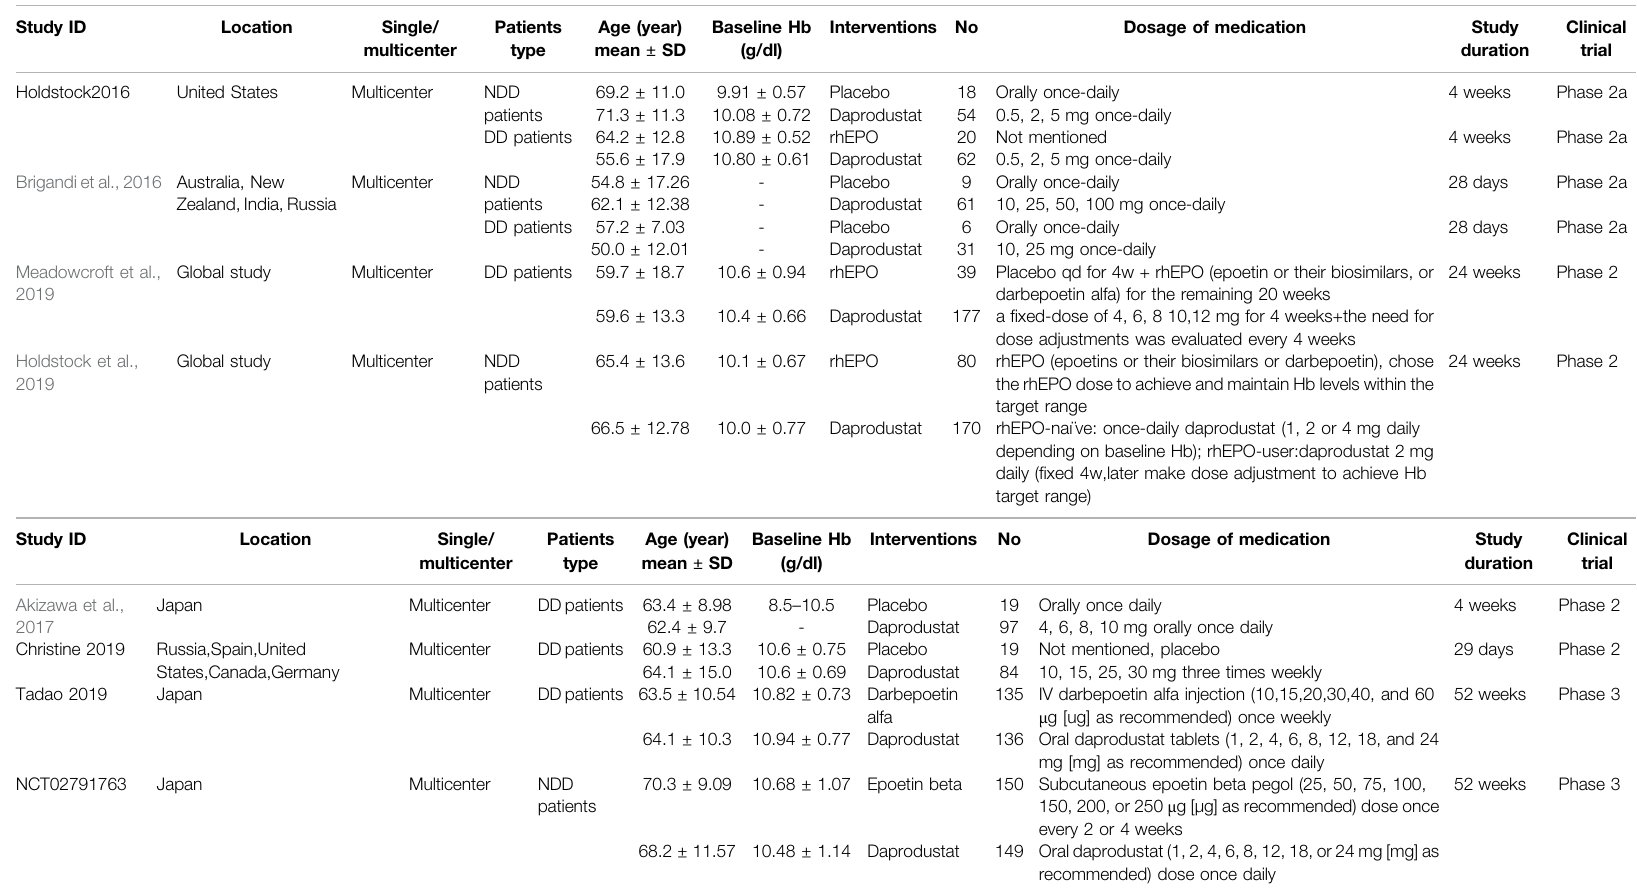
TABLE 1 | Characteristics of the included studies in the